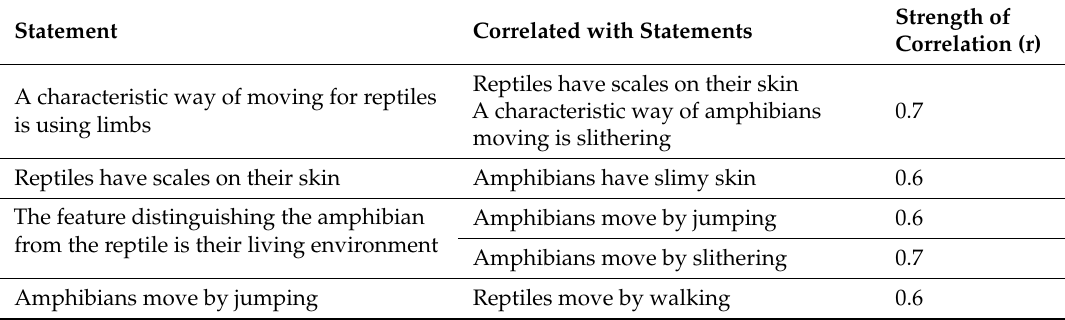
Table 3. Correlation between conceptions and alternative conceptions of amphibians and reptiles from questionnaires.